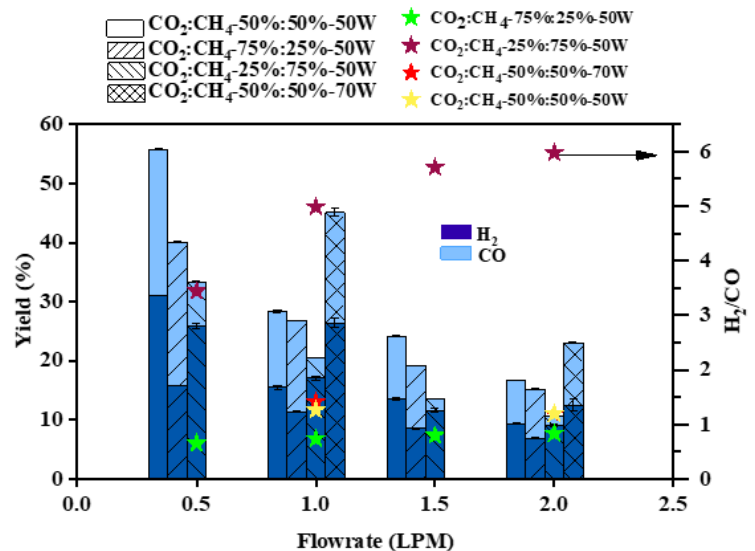
Figure 7. Effect of flow rate on gaseous product distribution.